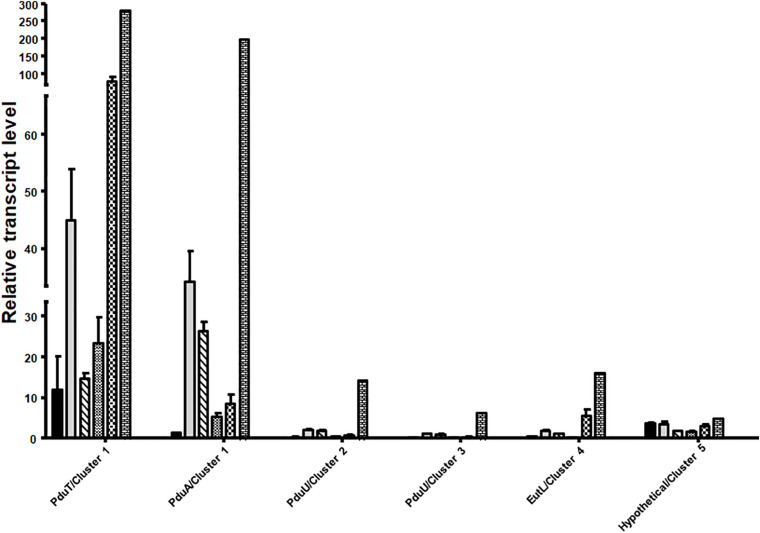
Differential regulation of the different BMC gene containing cluster in A. woodii. A. woodii was grown on 20 mM fructose, 20 mM ethylene glycol, 15 mM 1,2-PD, 20 mM 2,3-BD, 50 mM ethanol, or 5 mM acetaldehyde to early or mid-exponential phase. RNA was isolated from these cells and transcribed into cDNA and transcript levels were quantified by qPCR. Relative transcript levels of genes representative of each cluster, encoding PduT and PduA (cluster 1), PduU (cluster 2), PduU (cluster 3), EutL (cluster 4) or hypothetical (cluster 5) in A. woodii grown in fructose (black), ethylene glycol (gray), 1,2-PD (crossed), ethanol (small black dots), acetaldehyde (chequered), or 2,3-BD (bricks). Data are from three independent cultures and error bars represent one standard deviation.